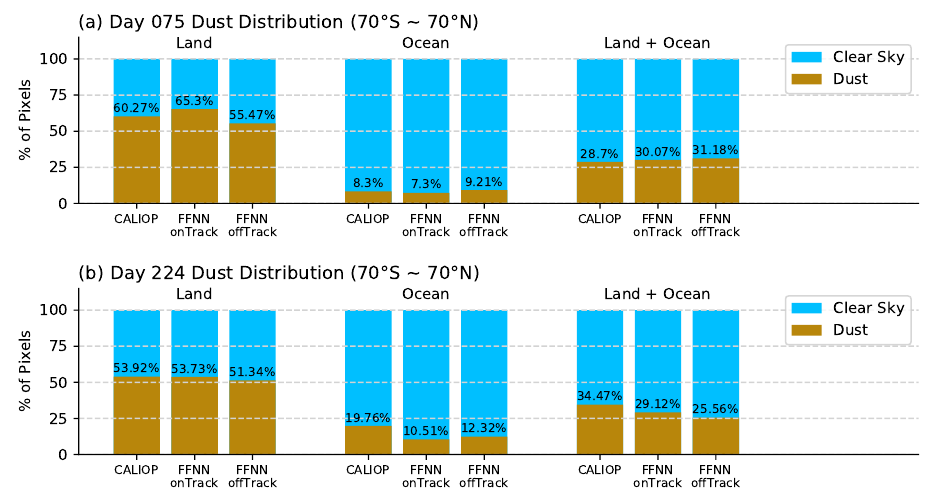
Figure 6. Predicted dust distribution for day ( a ) 075 (16 March 2014) and ( b ) 224 (12 August 2014). CALIOP and FFNN-onTrack shows the CALIOP product and FFNN prediction over the CALIOP and VIIRS collocated track, while FFNN-offTrack shows the FFNN prediction over the entire VIIRS granule for each